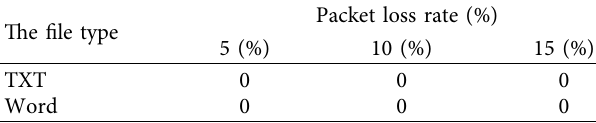
Table 2: Reliability experimental results (bit error rate).